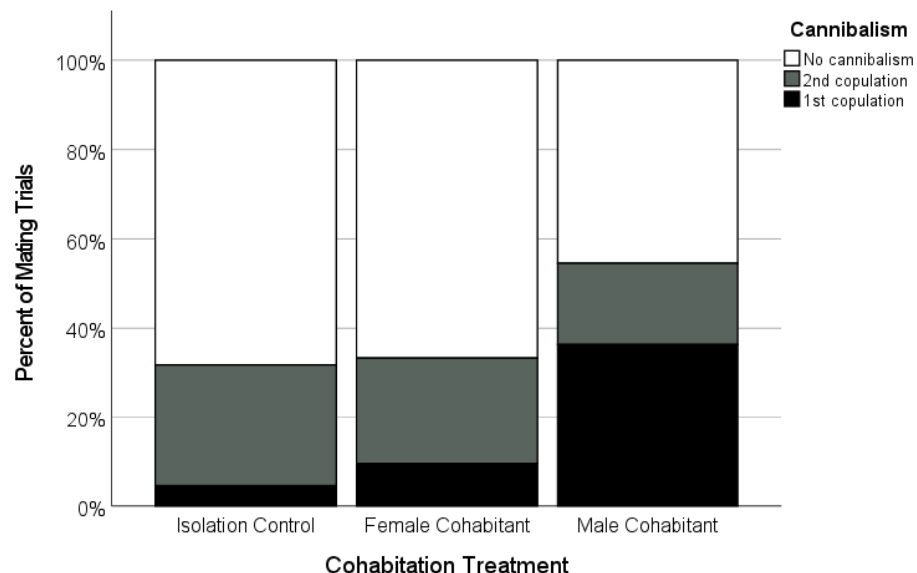
Figure 6. Occurrence and timing of sexual cannibalism by adult focal females that mated after being held as a subadult in one of three cohabitation treatments (Isolated, n = 20; Female-cohabitant, n = 20; Male-cohabitant, n = 19). Shown is the percentage of successful matings in which the females cannibalized (killed) the males during and after their first copulation (black, ‘premature cannibalism’), and during and after their second copulation (grey), as well as cases where the males survived the mating (white). Different letters above the bars (a, b) indicate differences in the occurrence of premature cannibalism (sequential Bonferroni post-hoc tests, p < 0.05).